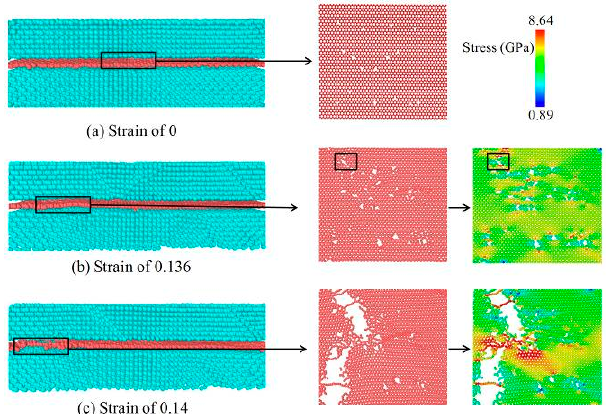
Figure 5. Fracture process and stress distribution of Random-20 under uniaxial tensile loading at the temperature of 300 K. ( a ) ε = 0 before the load is applied. ( b ) ε = 0.136 before reaching the stress limit. ( c ) ε = 0.14 after fracture failure.